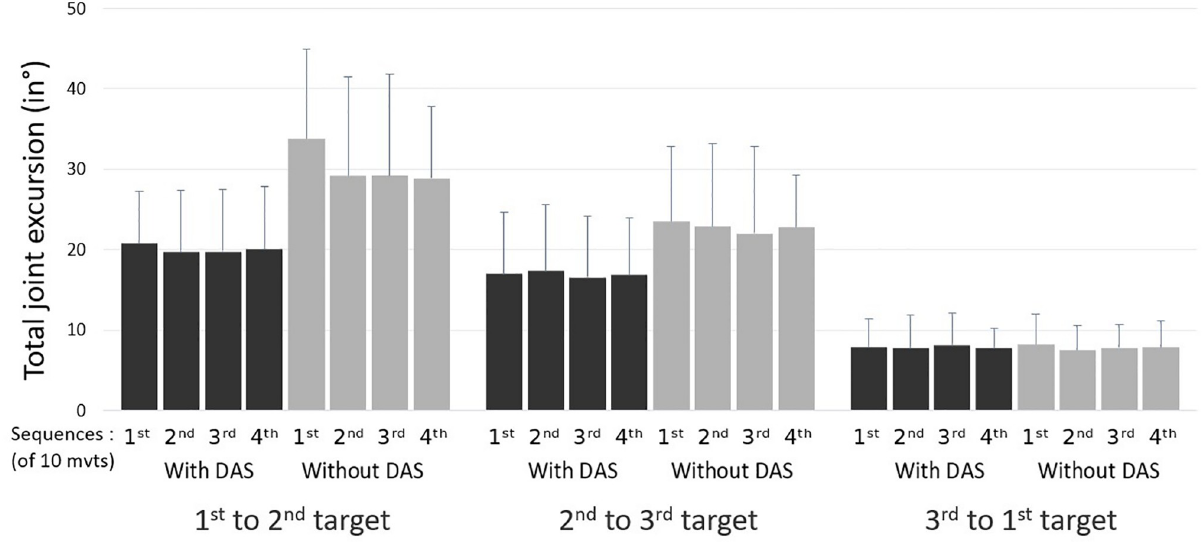
Fig 6. Mean total shoulder elevation excursion (in degrees; with standard deviation) during the dynamic task with and without the dynamic arm support (3D-DAS) (n =